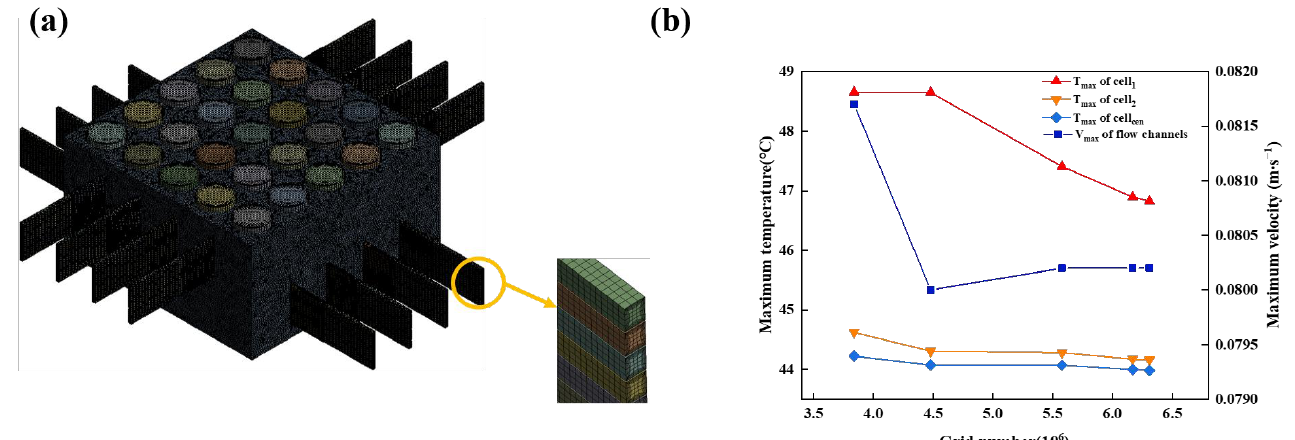
Figure 5. ( a ) The mesh of the simulation model; ( b ) Independence analysis of the grid